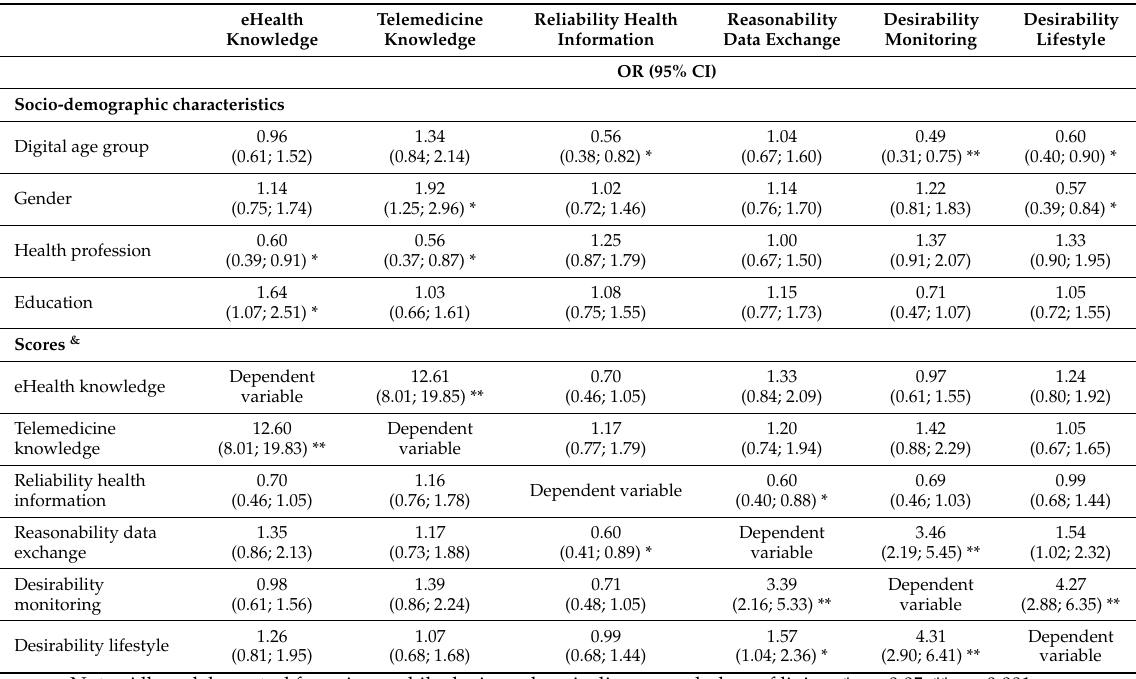
Binary logistic regression analysis for variables predicting connected health-related dichotomized scores. eHealth Telemedicine Reliability Health Reasonability Desirability Desirability Knowledge Knowledge Information Data Exchange Monitoring Lifestyle OR (95%